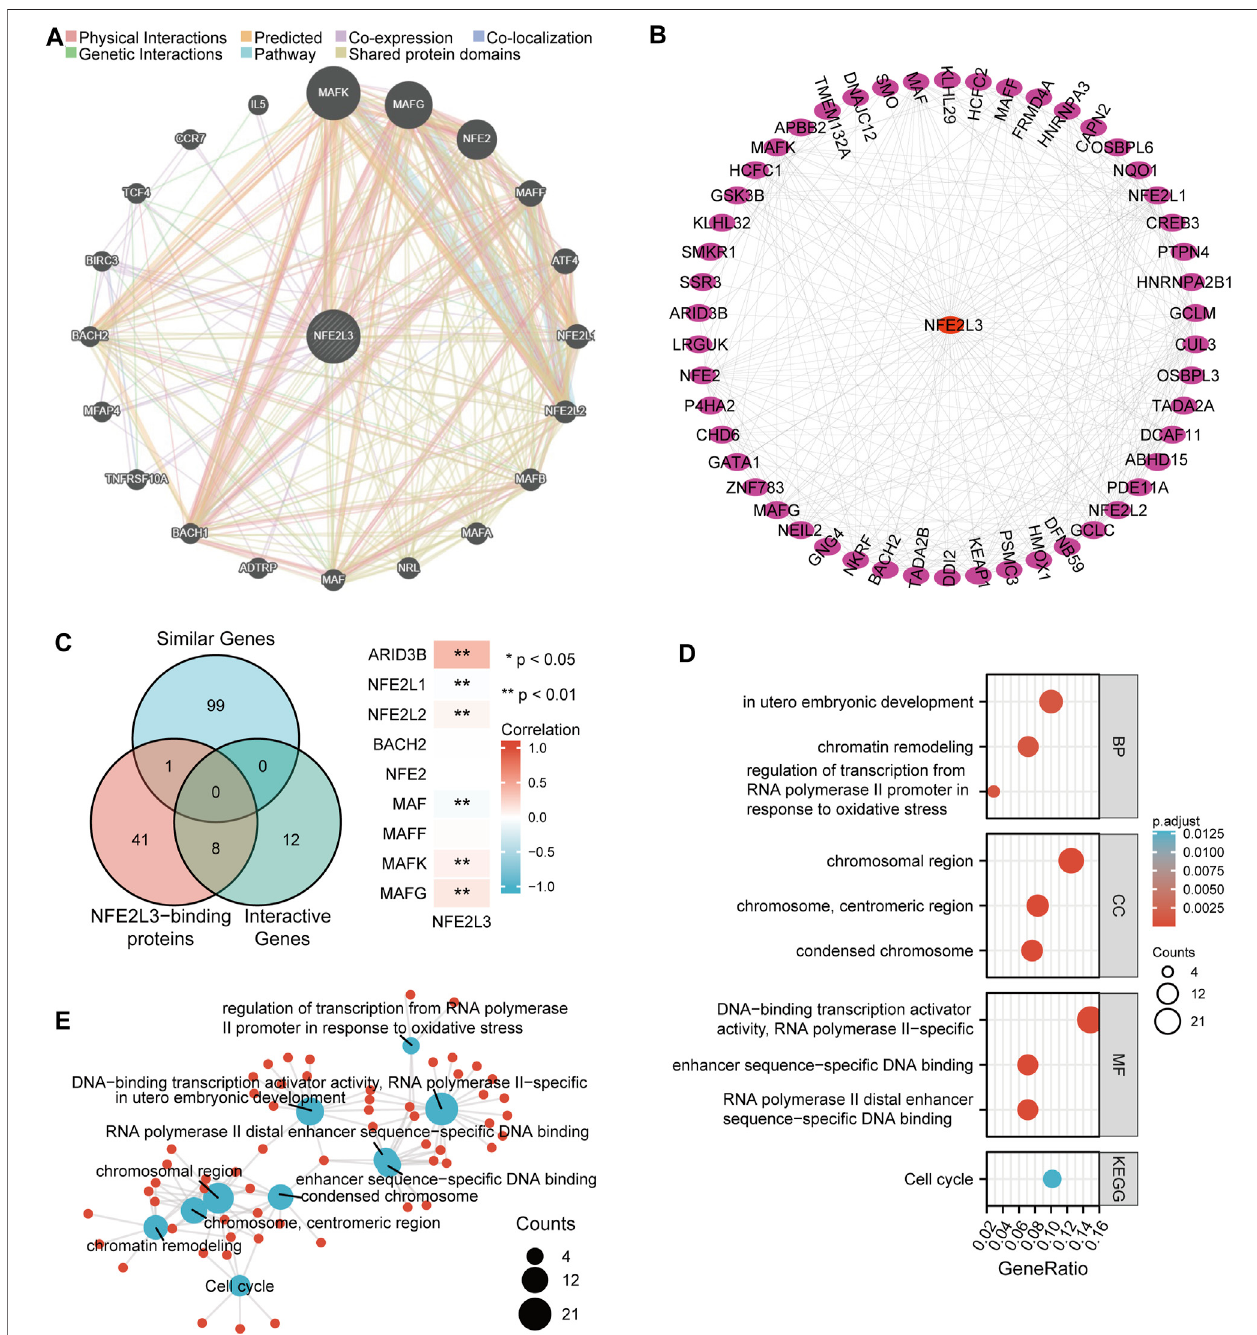
FIGURE 10 | Functional enrichment analysis of NFE2L3-related genes. (A) Top 20 interactive genes of NFE2L3. (B) Top 50 NFE2L3-binding proteins. (C) Venn diagram of NFE2L3-related genes and the correlation between expression levels of NFE2L3 and nine overlapping genes. (D,E) GO and KEGG pathway enrichment analysis of NFE2L3-related